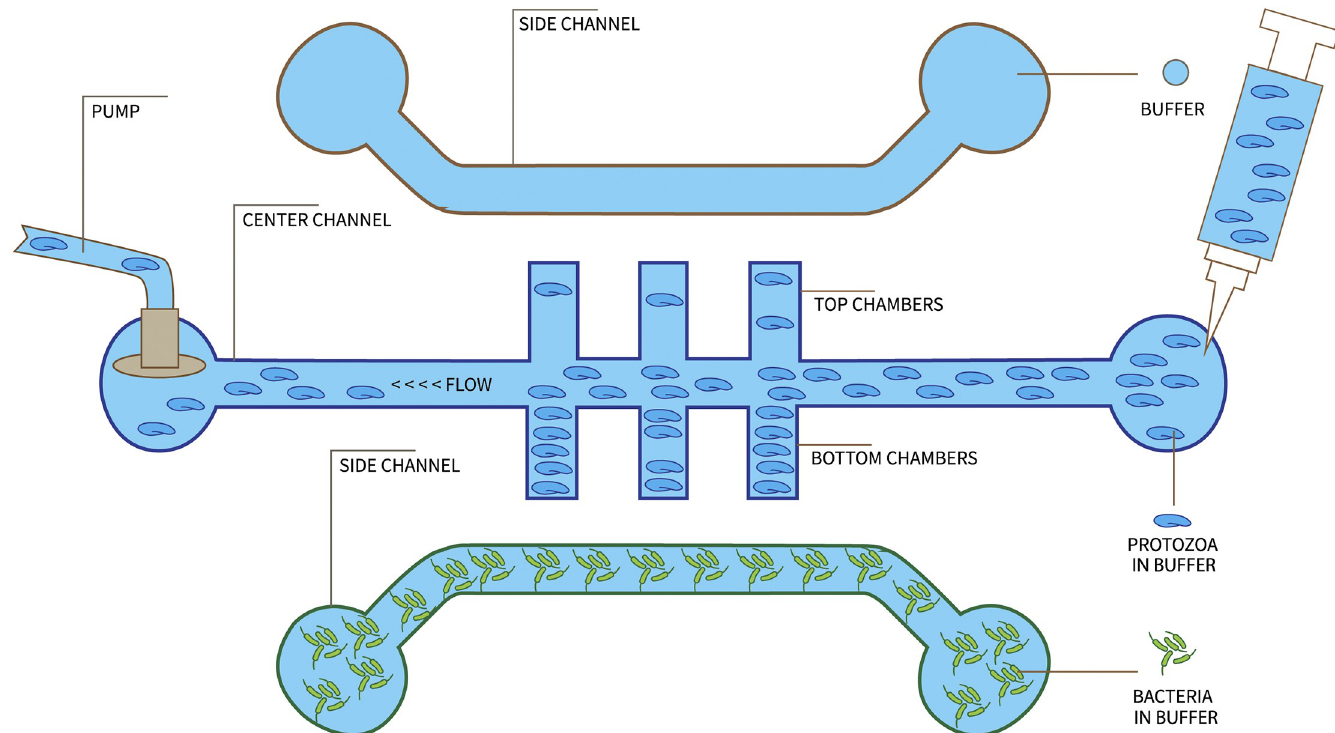
Fig 1. Conceptual design of the microfluidic device used in this study. The sample was introduced from the right end of the center channel. The chambers are named as 1 st , 2 nd , and 3 rd (from right to left) set of chambers to represent the sequences of a sample to reach the entrances of the